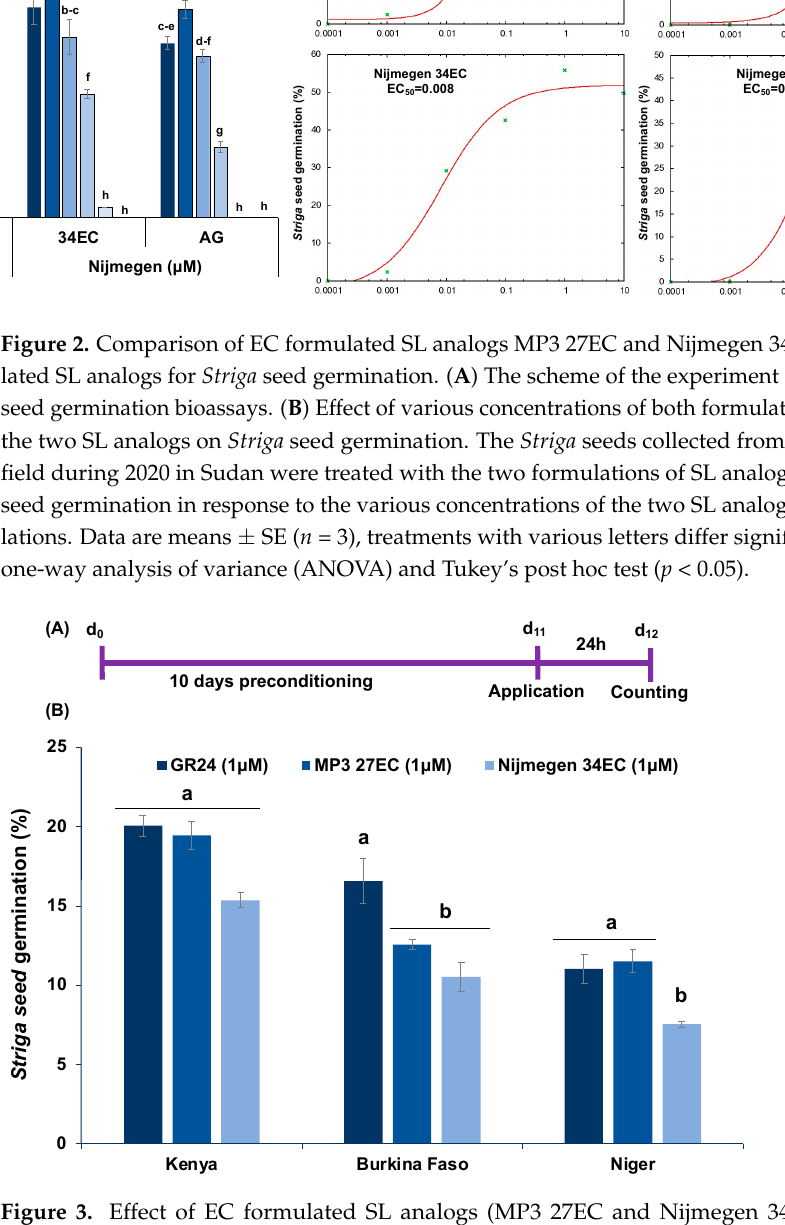
Figure 3. Effect of EC formulated SL analogs (MP3 27EC and Nijmegen 34EC) on Striga seed germination collected from a maize field in Kenya, pearl millet fields in Burkina Faso, and Niger. ( A ) Scheme of the experiment conducted for Striga seed germination bioassays. ( B ) Striga seed germination of various ecotype in response to MP3 27EC and Nijmegen 34EC. Data are means ± SE ( n = 7). For each SL analog, treatments with various letters differ significantly according to one-way analysis of variance (ANOVA) and Tukey’s post hoc test ( p < 0.05).